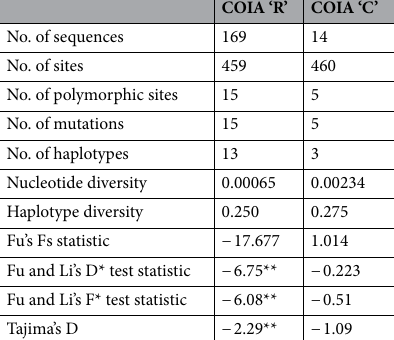
Table 2. Comparison between genetic diversity of FAW sister strains in India. (** P < 0.02).